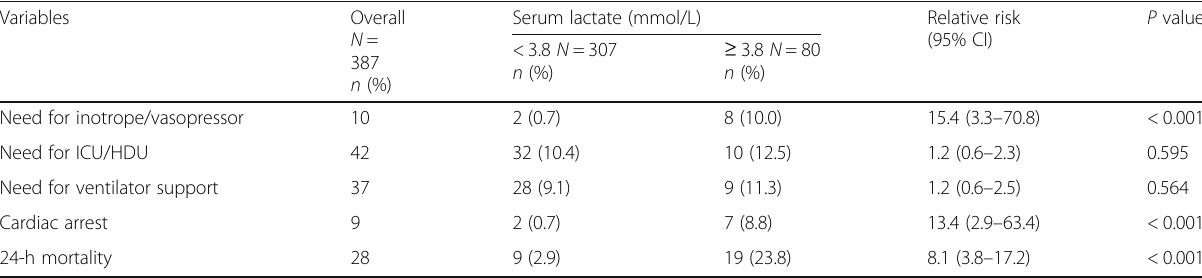
Table 6 24-h serious adverse events with distribution of high vs. low lactate level (high ≥ 3.8 mmol/L and low < 3.8 mmol/L)